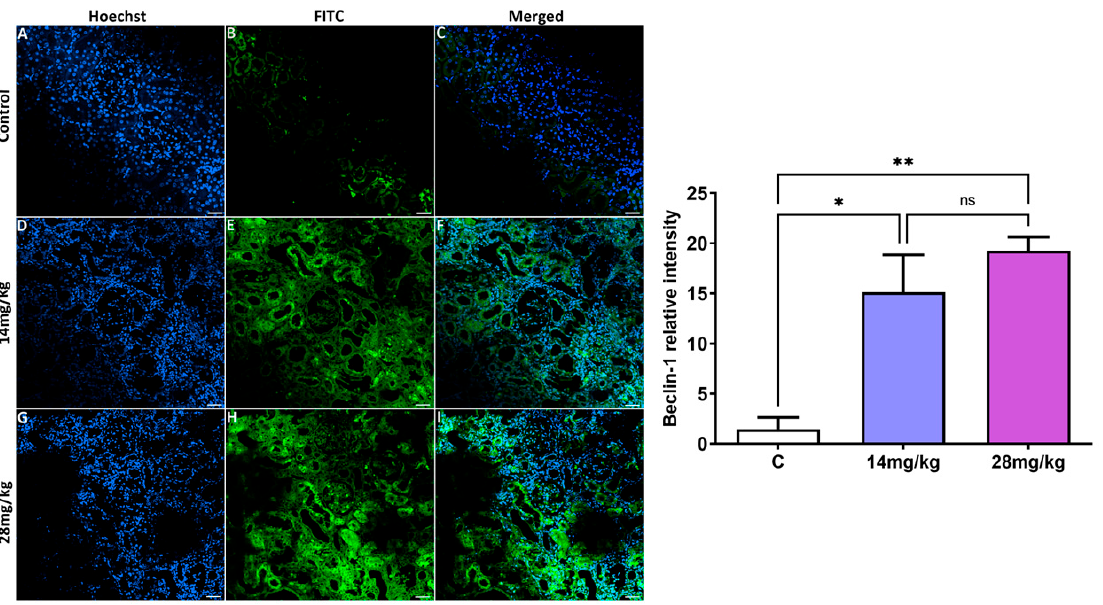
Figure 4. Effects of prenatal acephate exposure on the autophagic marker Beclin-1 in adult rat offspring. Beclin-1 was evaluated via immunofluorescence staining ( A – I ) and measurement of the relative fluorescence intensity, which is then quantified using the Zen 3.1 service (ZEN lite) and quantified using the GraphPad Prism 9 program. The immunofluorescence analysis of Beclin-1 revealed the upregulation of this biomarker in both treatment groups (14 and 28 mg/kg) compared with the control group. All data are expressed as mean ± standard deviation (SD). Scale bar = 200 µ m. * p < 0.05; ** p < 0.01 ( n = 8), ns: